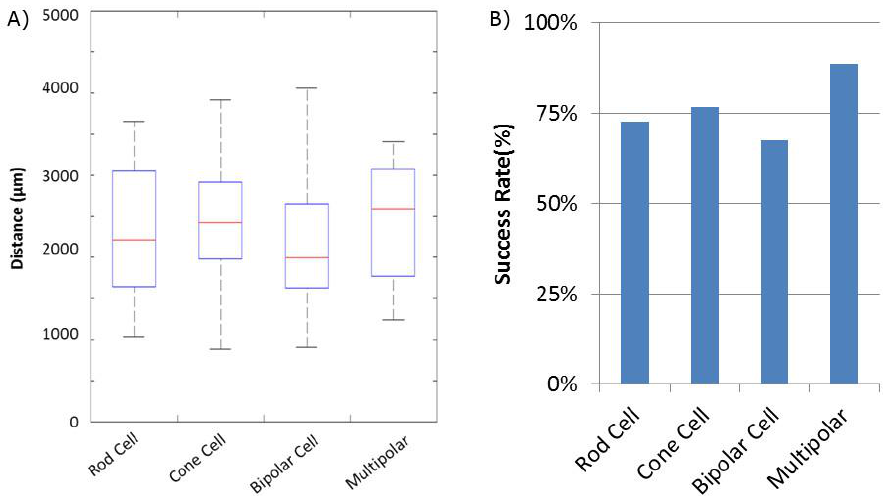
Figure 3. Quantification of retinal cell movement during experiments. All cell types, except for Mueller cells, were moved. ( A ) Distance each cell type was tweezed. Average distance indicated by the Red Line. Blue box indicates 25% quartile. Dashed lines with end caps indicate shortest and longest distance each cell type was moved. ( B ) Success rate of movement for each cell type. Success was defined as identifying a moveable cell and being able to place it such that some part of the cell was on an MEA electrode.